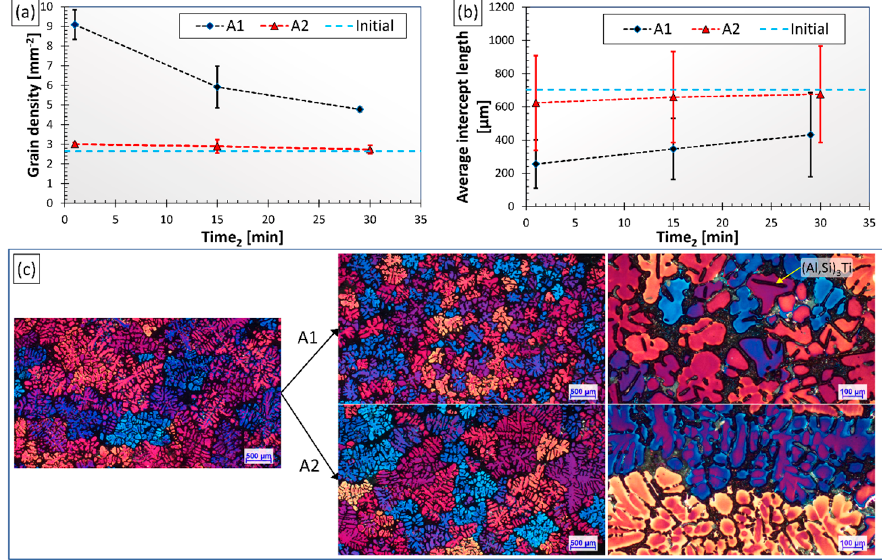
Figure 2. ( a ) Average grain number density and ( b ) mean intercept length results, ( c ) grain structure of the RPT sample cast before and after Ti-alloying for both experiments. of the RPT sample cast before and after Ti-alloying for both